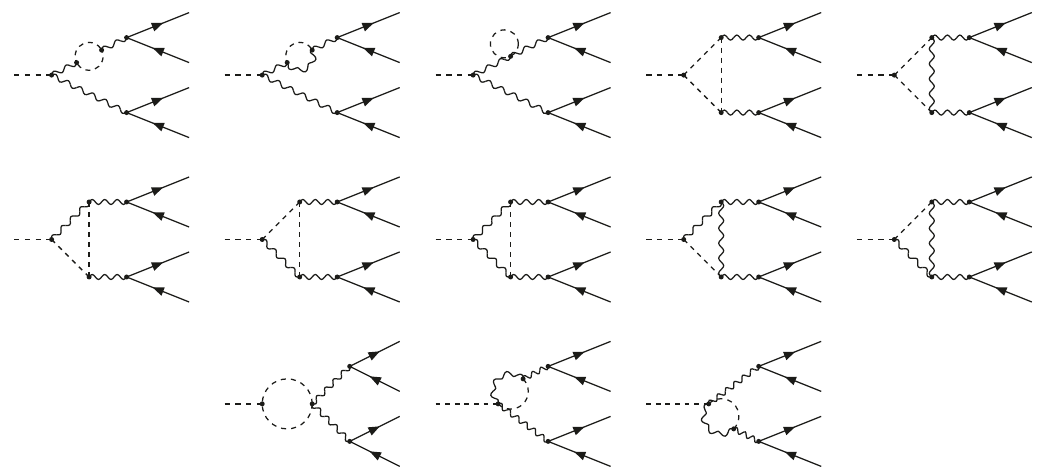
Figure 6 . Loop diagrams involving internal scalar particles. Each internal scalar line can be either a light or a heavy Higgs (cid:12)eld; self-energy topologies are shown only for one of the intermediate gauge bosons.